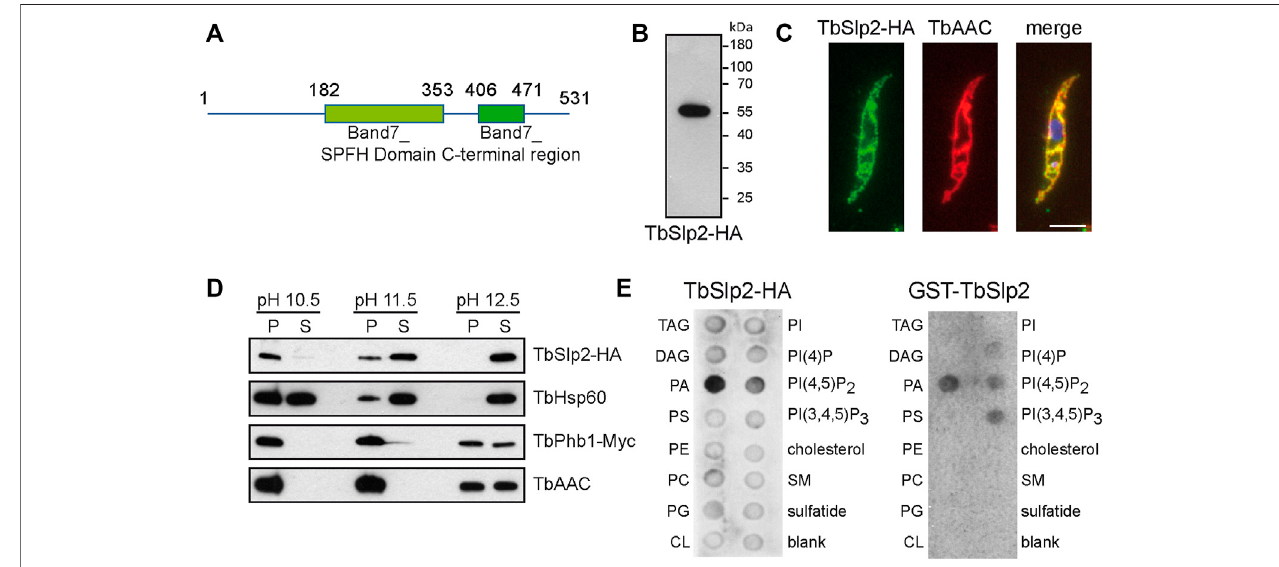
FIGURE1| CharacterizationofTbSlp2in T.brucei . (A) SchematicofTbSlp2showingthelocationoftheconservedBand7_SPFHdomainandtheC-terminalregion with the amino acid numbers indicated. (B) SDS-PAGE and immunoblot analysis of TbSlp2-HA expressed in T. brucei procyclic forms. (C) T. brucei procyclic forms expressing TbSlp2-HA were incubated with antibodies against HA and the mitochondrial ADP/ATP carrier (TbAAC) and analyzed by fl uorescence microscopy. Scale bar: 5 µm (D) Carbonate extraction of TbSlp2-HA. Mitochondrial membranes were treated with 0.1 M Na 2 CO 3 at pH 10.5, 11.5 and 12.5, separated by ultracentrifugation into soluble (S) and membrane (P) fractions, and analyzed by immunoblotting using primary antibodies against HA, TbHsp60 (soluble matrix protein), orTbPhb1andTbAAC(integralmembrane proteins). (E) TbSlp2-HAisolatedfrom T.brucei (leftpanel) andrecombinantGST-TbSlp2puri fi edfrom E.coli (rightpanel) was added to membranes containing pre-spotted lipids and protein binding was visualized using antibodies against HA and GST, respectively. TAG: triacylglycerol; DAG: diacylglycerol;PA:phosphatidicacid;PS:phosphatidylserine;PE:phosphatidylethanolamine;PC:phosphatidylcholine; PG:phosphatidylglycerol; CL: cardiolipin; PI: phosphatidylinositol; PI(4)P: phosphatidylinositol 4-phosphate; PI(4,5)P2: phosphatidylinositol 4,5-biphosphate; PI(3,4,5)P3: phosphatidylinositol 3,4,5- triphosphate; SM: